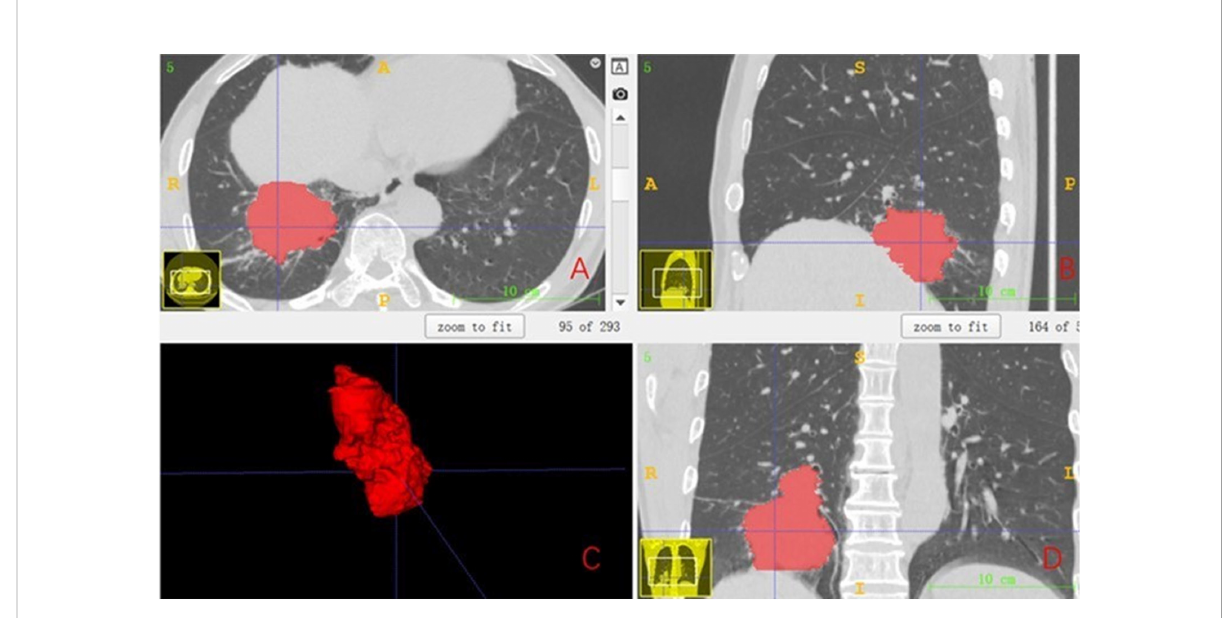
FIGURE 1 The fi nal ROI. (A) Segmentation results of the cross section. (B) Segmentation results of the sagittal plane. (C) Three-dimensional (3D) visualization effect of the tumor area. (D) Segmentation results of the coronal plane. ROI, region of